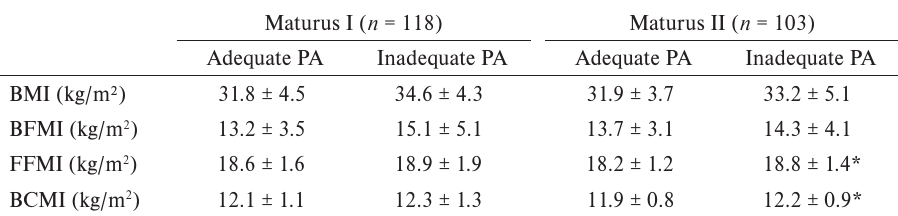
Indices of selected body composition health indicators Maturus I ( n = 118) Maturus II ( n = 103) Adequate PA Inadequate